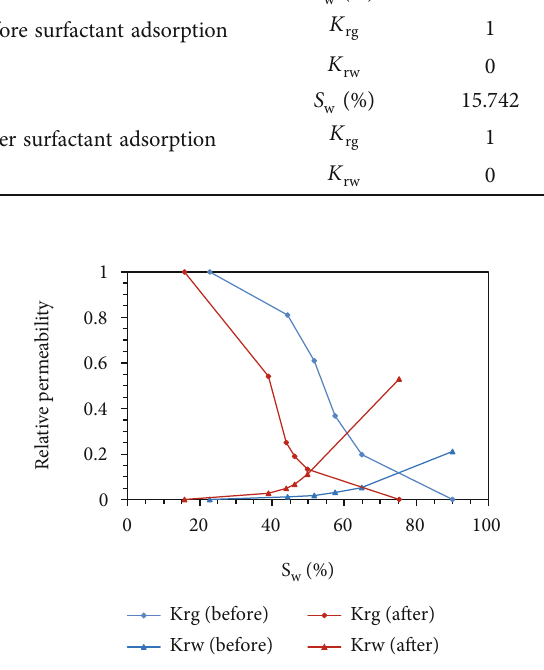
Figure 2: Relative permeability curves of the coal before and after surfactant